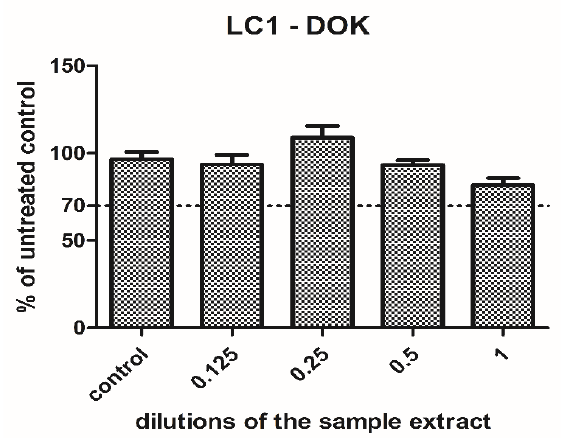
Figure 3. Cell viability of the dysplastic oral keratinocytes cells treated with LC1 extract in different dilutions. The results are expressed as the percentage of untreated controls, n = 3, media + SD.